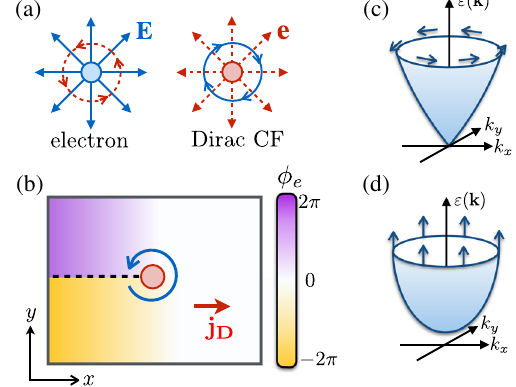
FIG. 1. Schematic of charge vortex duality for transport. (a) An electron (blue dot) is a source of electric field E (blue line) and − 4 π flux of the emergent gauge field b (circulating dashed red line indicates winding of phase for Dirac composite fermion). The Dirac composite fermion object (red dot) is a dual object that is a source of emergent electric field lines e (dashed red lines) and 4 π flux of the electron phase (circulating blue line). Panel (b) shows the electron phase ϕ , winding by 4 π across the y e direction for each composite fermion propagating along x . Panels (c,d) schematically depict the composite fermion dispersion and Fermi-surface pseudospin texture for the Dirac ( π Berry phase) and HLR (0 Berry phase),